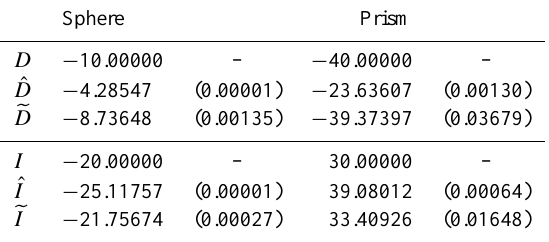
Table 2. Test with the synthetic data (Fig. 3b) produced by a sphere and a rectangular prism. Comparison between the estimated and true values of the magnetization declination D and inclination I . The uncertainties σ D and σ I (shown between parentheses) are cal- culated by using Eqs. (34) and (35). All values are in degrees ( ◦ ). We use a caret ( ∧ ) and a tilde ( ∼ ) to distinguish the quantities computed by using, respectively, the least-squares ˆ h and robust e h estimates. Sphere